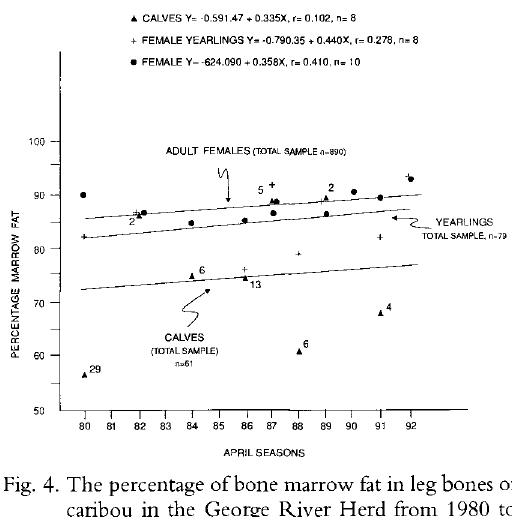
Fig. 4. The percentage of bone marrow fat in leg bones of caribou in the George River Herd from 1980 to 1992 showed no trend as the herd